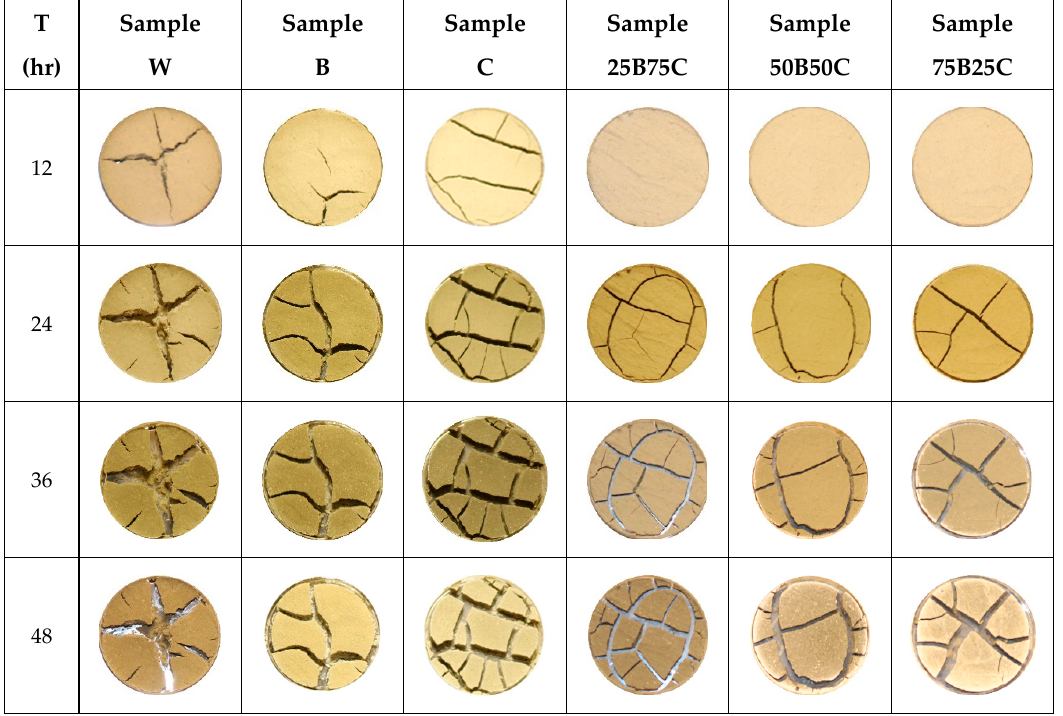
Figure 4. Spatiotemporal evolution of crack pattern in bentonite treated with different solutions (time = 12, 24, 36, and 48 hours).